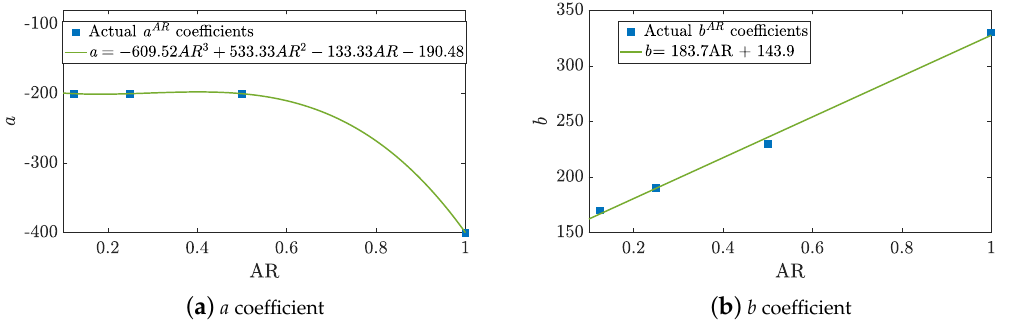
Figure 5. Re cr fitting